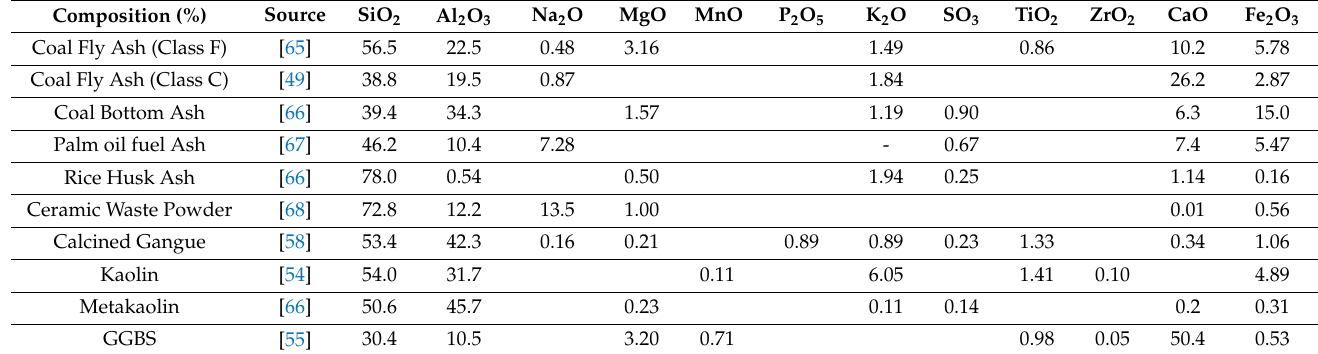
Table 1. Oxide composition of different raw materials.